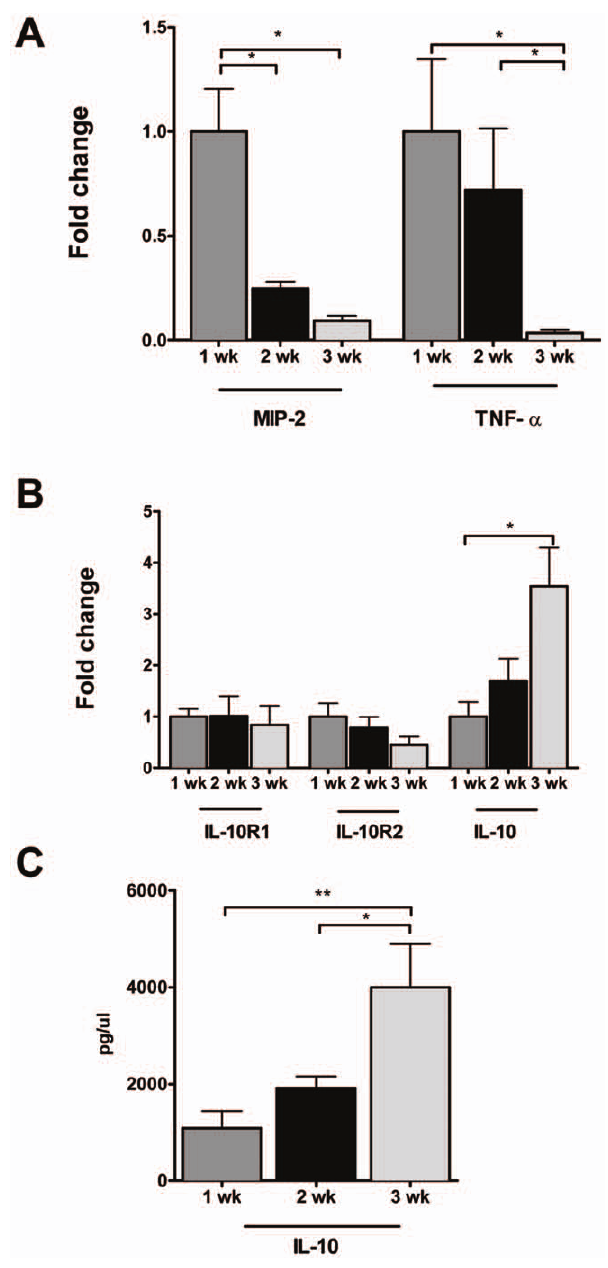
Figure 1. The baseline colonic expression of cytokines and IL- 10 receptor subunits is developmentally regulated prior to weaning. Cytokine and IL-10 receptor subunit expression was analyzed by real time PCR in whole colon from 1, 2 and 3 week-old C57BL/6J mice. The data represent mean fold change 6 SEM, relative to 1 week- old mice (A, B). C. IL-10 cytokine levels in supernatants of whole colon incubated for 24 hours were assayed by ELISA and depicted as mean concentration 6 SEM (*p , 0.05, n=5 2 7 mice per age